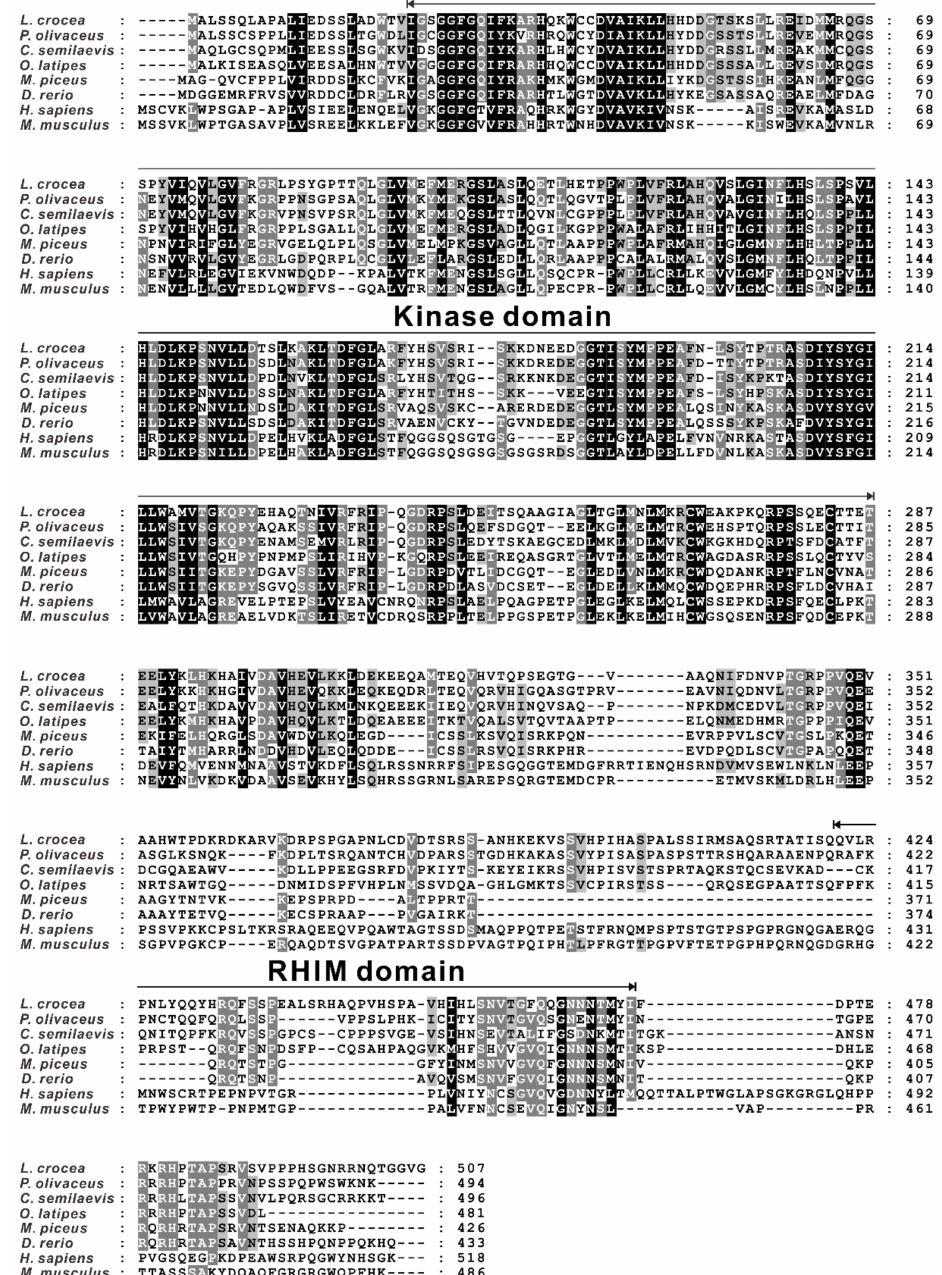
Figure 1. Multiple alignment of the protein sequence of Lc -RIP3 with other vertebrate RIP3. The amino acid sequence of Lc -RIP3 was compared with other vertebrate RIP3 by using Clustal X and the GeneDoc program. The black shaded areas indicate positions where all the sequences share the same amino acid residue whereas the gray and light gray shaded areas denote the conservative and semi-conservative amino acid substitutions, respectively. The kinase domain and RHIM domain are indicated with black